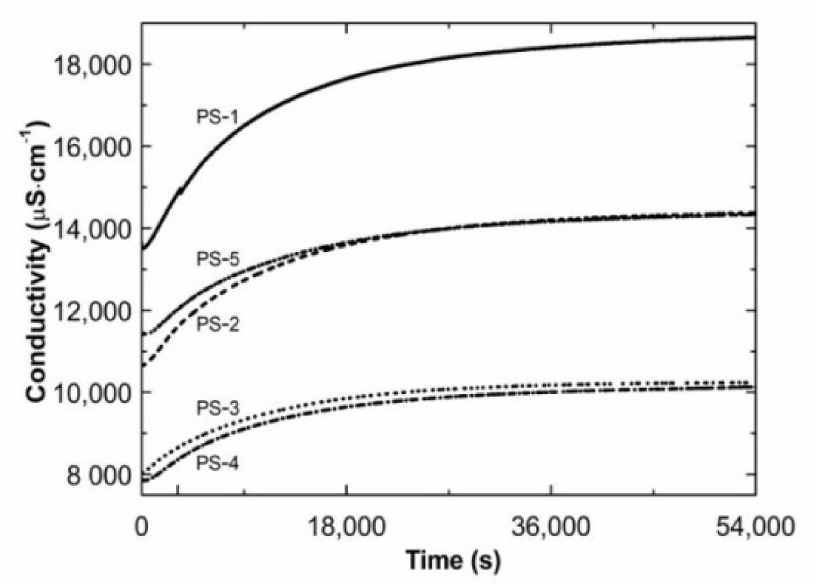
Figure 4. The changes of conductivity vs. time in the post-reaction mixtures of PS1–PS5 over cooling